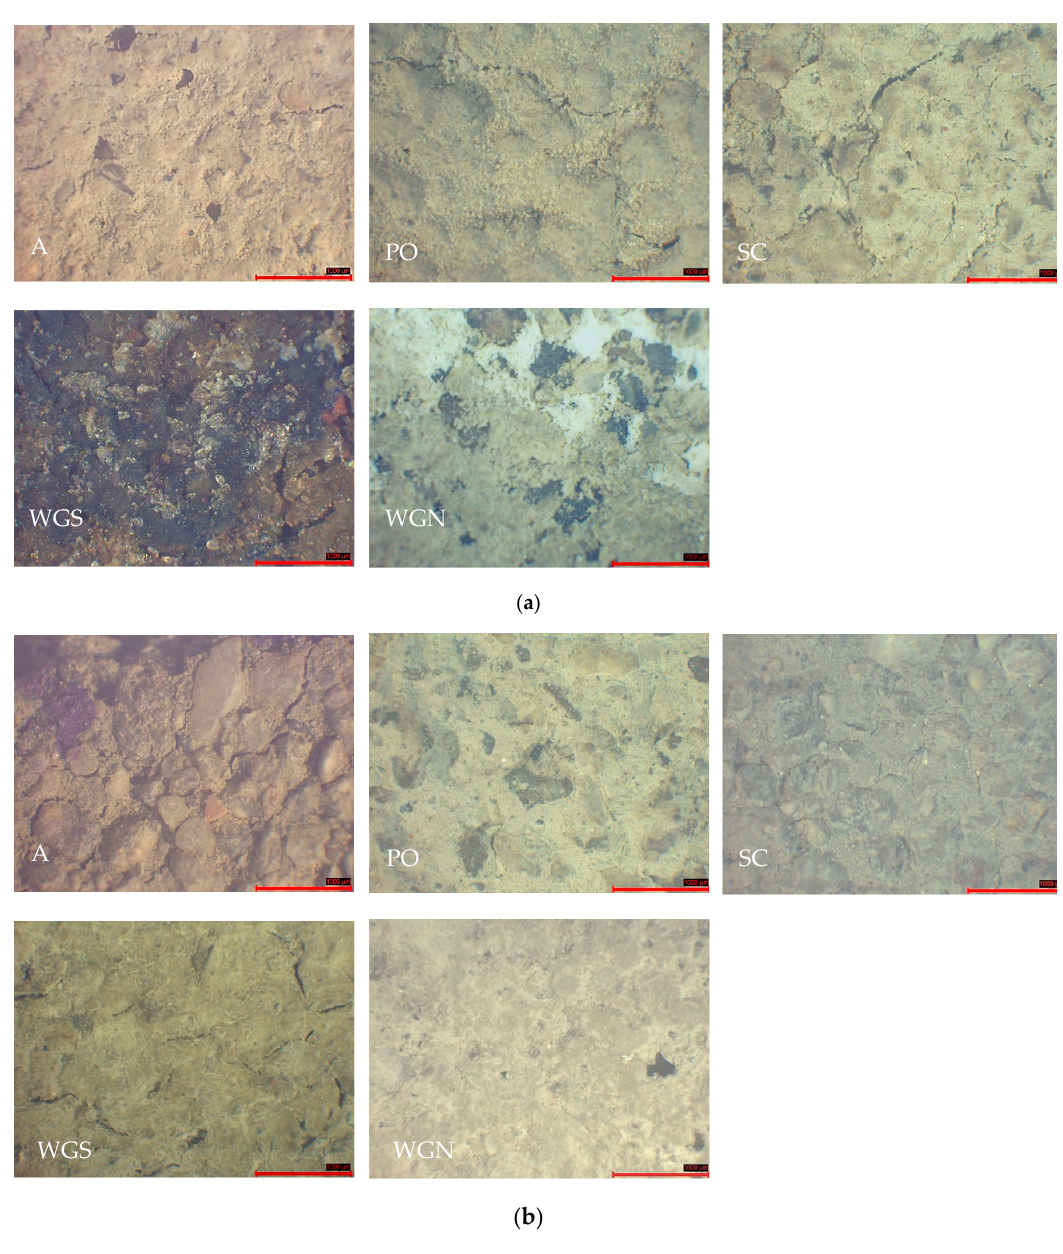
Figure 7. Stereoscopic observation of the mortars after the ( a ) freeze–thaw and ( b ) wet–dry cycles (scale: 1000 μ m).